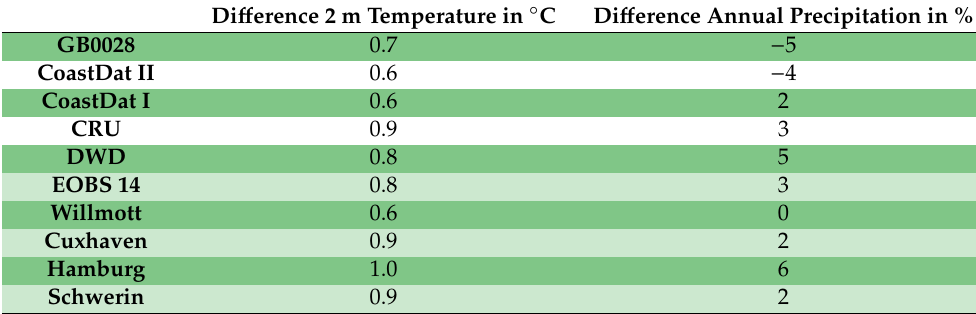
Table 1. Di ff erence of the mean of the two time slices (1986–2014 / 15 and 1961–1990) for temperature and annual precipitation for various data sets averaged over the metropolitan region of Hamburg (Figure 1) and DWD station measurements data for the cities Cuxhaven, Hamburg, and Schwerin. Di ff erence 2 m Temperature in ◦ C Di ff erence Annual Precipitation in